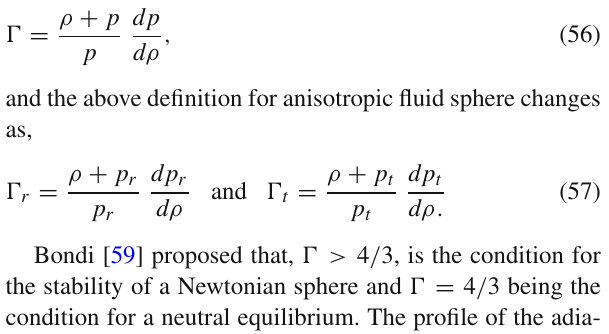
values of (cid:15) r , (cid:15) t are obtained in Table 4. We note that